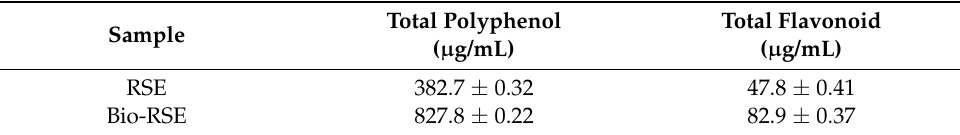
Table 1. Changes in the content of total polyphenols and flavonoids in R. sachalinensis